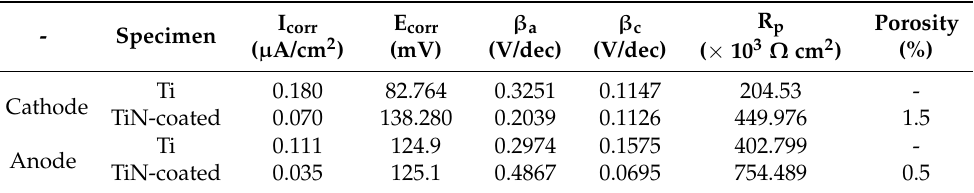
Table 4. Electrochemical parameters deduced from potentiodynamic polarization curves in Figure 4 of titanium substrate and TiN-coated